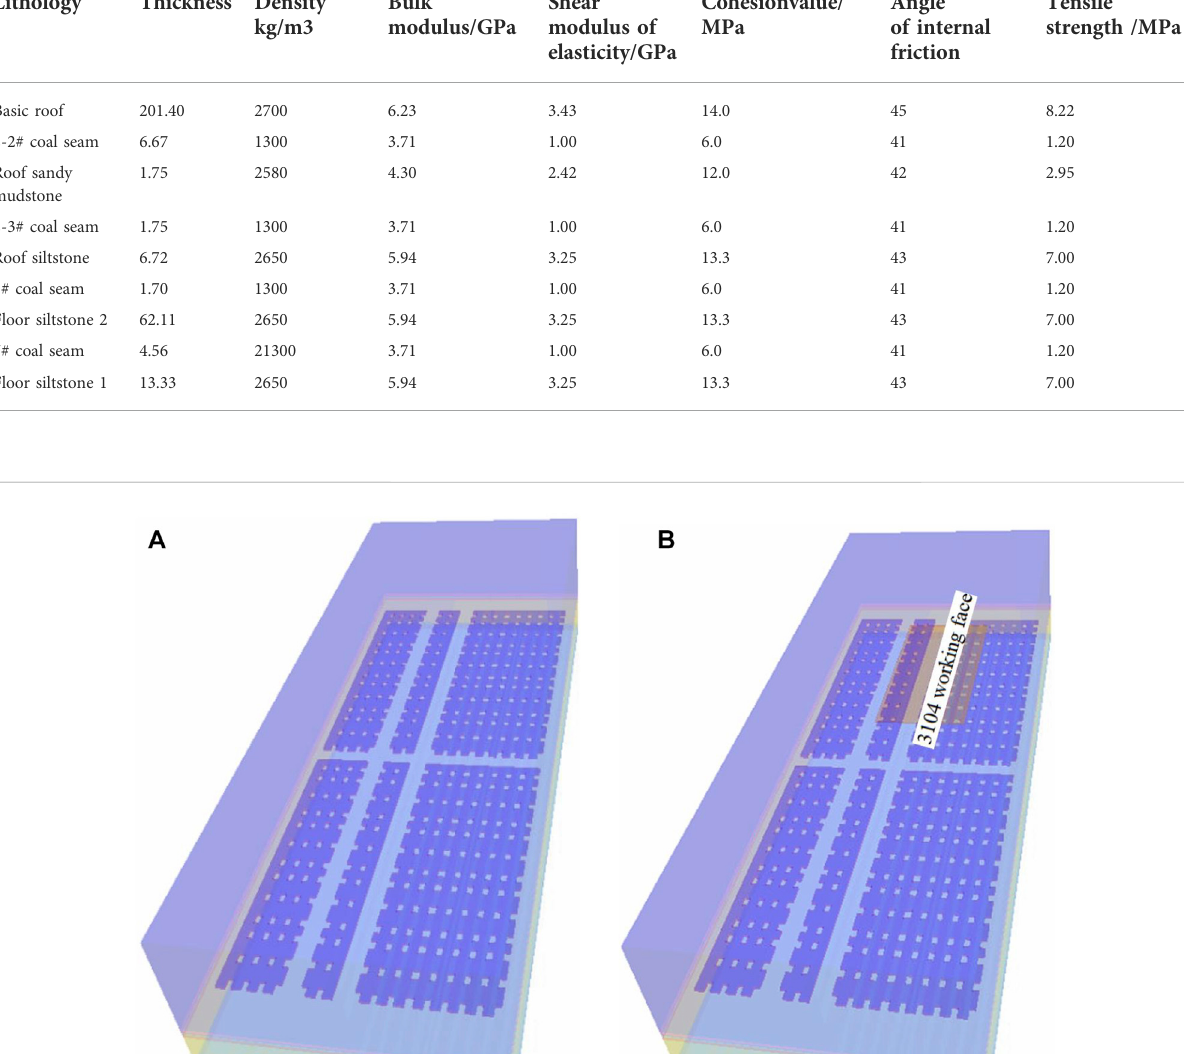
Frontiers in Energy